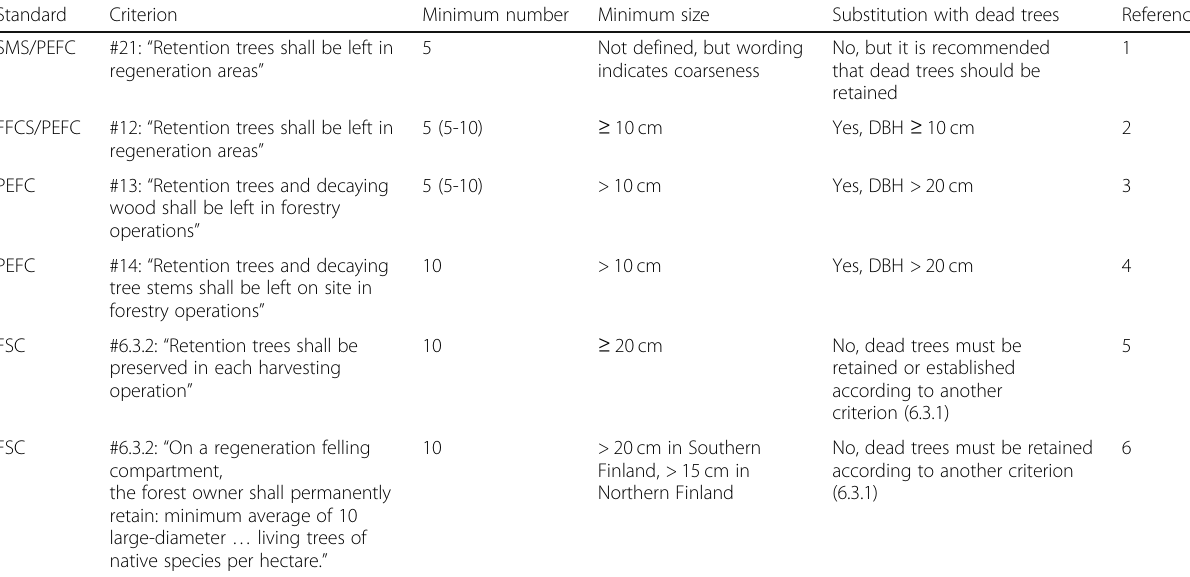
Table 1 Contents of retention-tree criteria of the national Finnish forest certification standards PEFC and FSC during 1998 – 2014. Minimum number: minimum number of required retention trees/hectare; Minimum size: minimum DBH (cm) required for retention trees. Substitution with dead trees: are dead trees accepted as substitutes for living retention trees or not. References: 1 = Metsäsertifioinnin valmiusprojekti 1998, 2 = Metsäsertifioinnin standardityöryhmä 2003, 3 = PEFC Finland 2009, 4 = PEFC Finland 2014, 5 = The Board of the Finnish FSC Association 2005, 6 = Finnish FSC Association